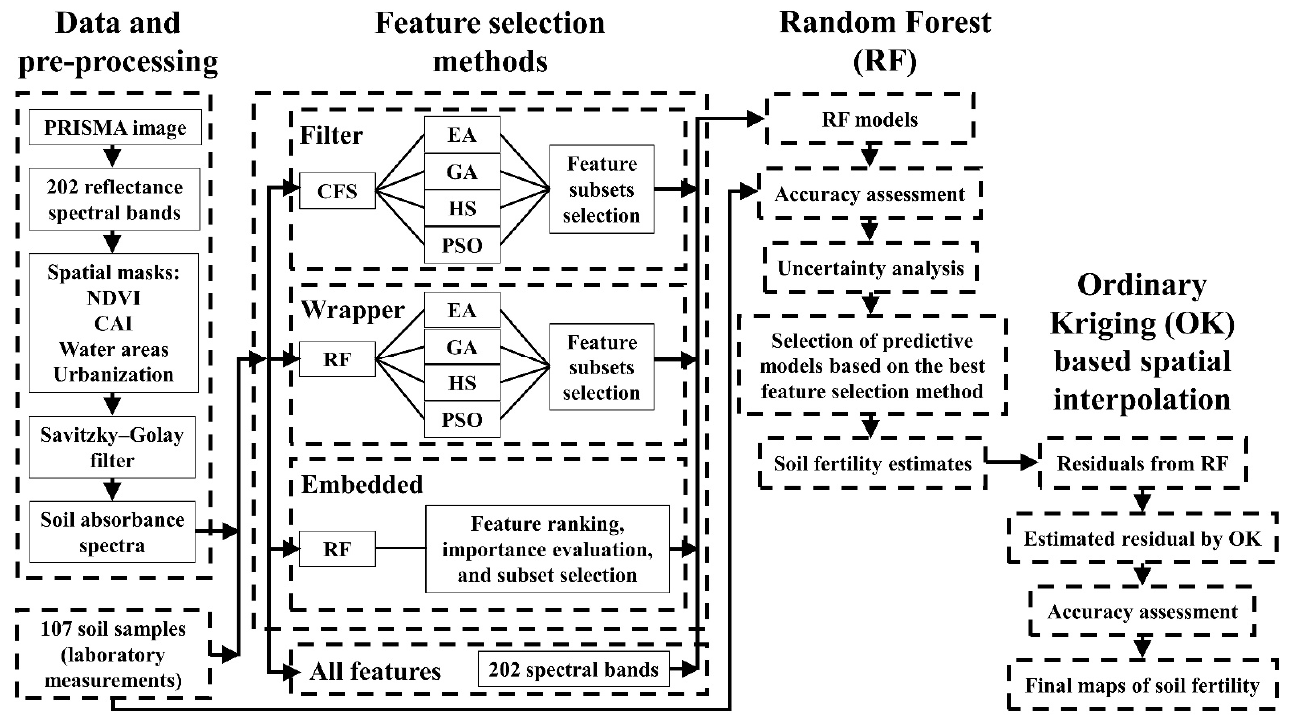
Figure 2. Methodology